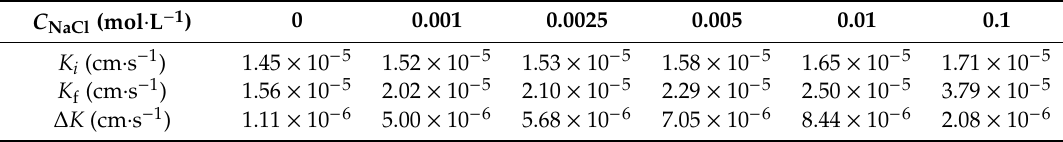
Figure 4. Variation characteristics of saturated hydraulic conductivity. ( a ) The change of saturated hydraulic conductivity ( K sat ) with permeation time and ( b ) distribution range of the K sat value. Table 4. Change in the saturated hydraulic conductivity of the samples.